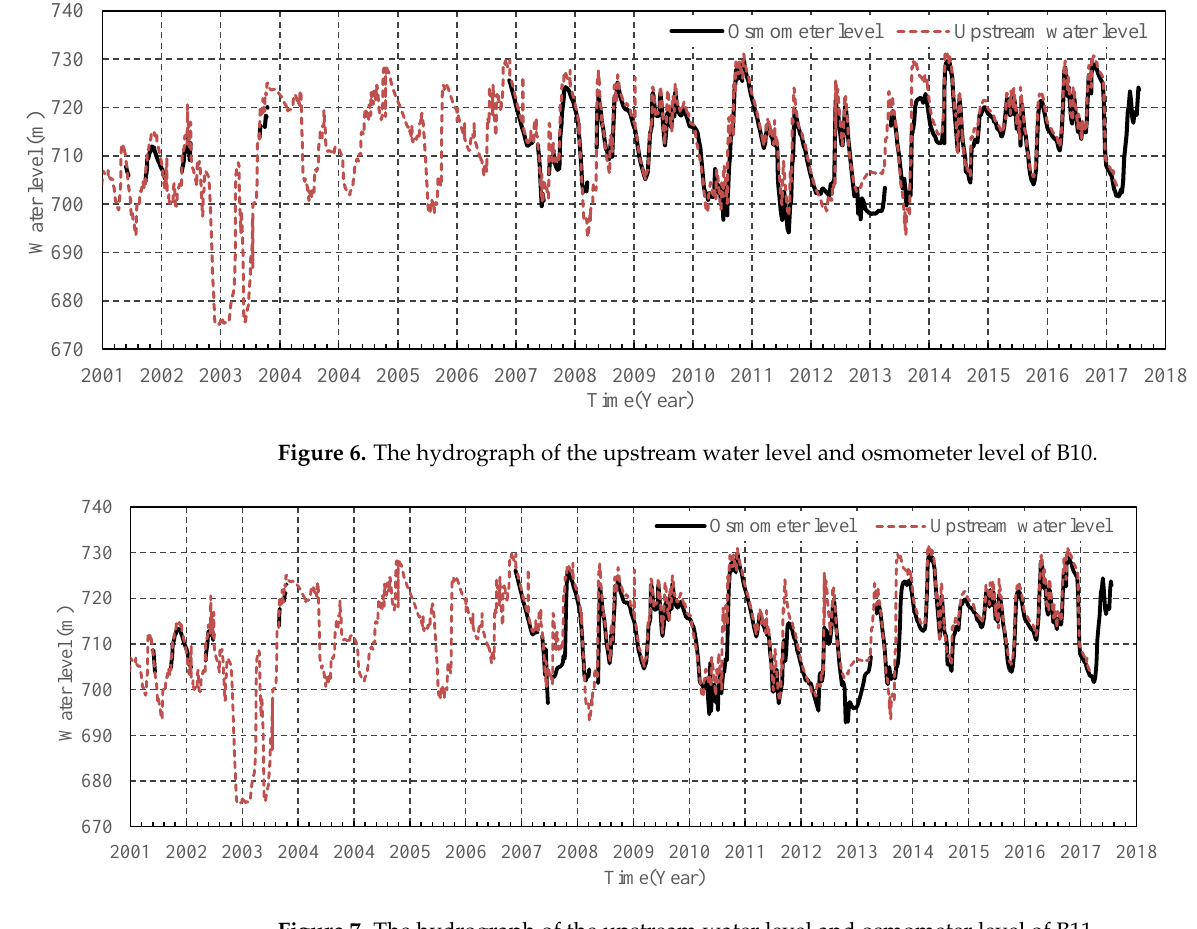
Figure 7. The hydrograph of the upstream water level and osmometer level of B11.